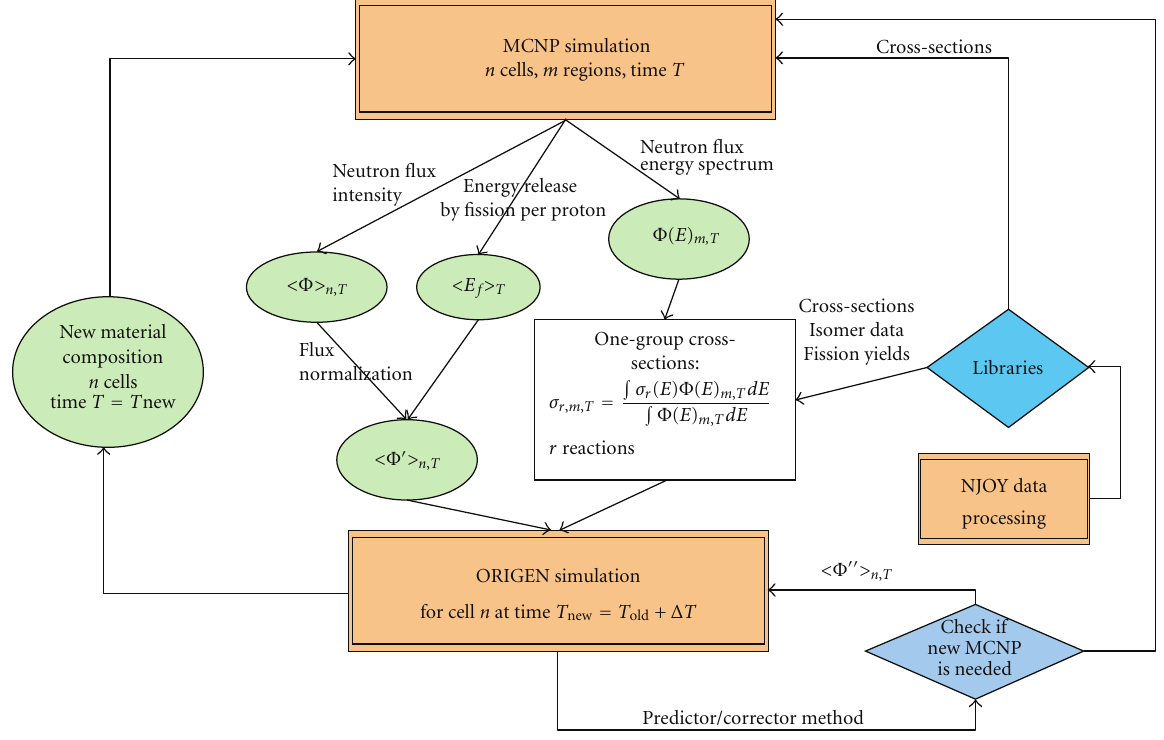
Figure 1: EVOLCODE 2 cycle data flow